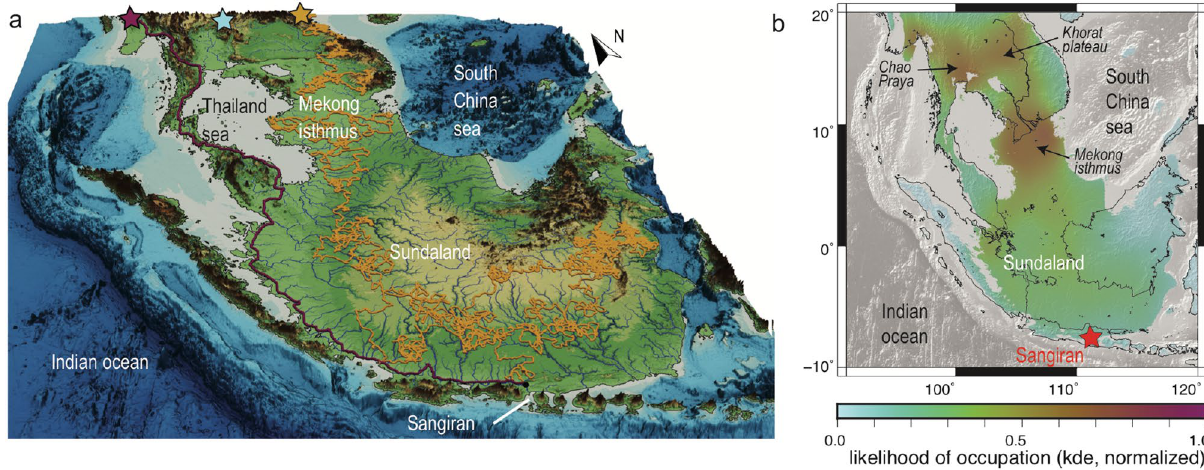
Figure 3. Migration pathways of H. erectus across Sundaland during Early Pleistocene. ( a ) Reconstructed landscape ca. 1.8 Ma (model goSPL 32 ). The underlying physiography, with overprinted modeled rivers, converts into a map of resistance to displacement that serves to compute the migration pathways, either using a least-cost path algorithm shown for the Myanmar entry point (purple), or a mechanistic movement model ( SiMRiv 30 ) exemplified for the Vietnam entry point (orange). Blue star locates the Thailand entry point. ( b ) Statistical analysis of the pathways of H. erectus migration to Sangiran, from 3000 simulations (1000 per entry point). The kernel density estimation (kde, normalized) indicates the likelihood that hominins came across a given region (combined for the three entry points). Map on panel ( a , b ). were respectively made using Paraview (www. parav iew. org) and GMT 5 (www. gener ic- mappi ng- tools. org) 24